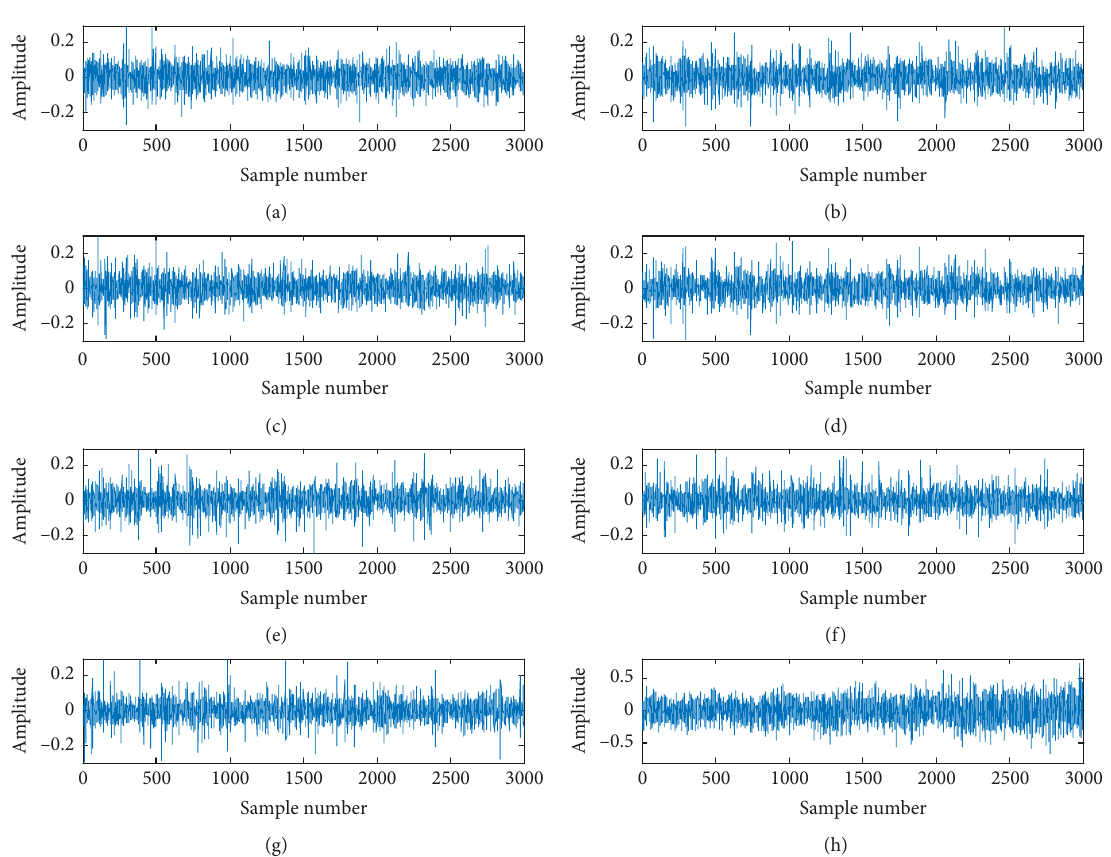
Figure 29: Multiresolution DMD modes of the pitch error gear fault signal.